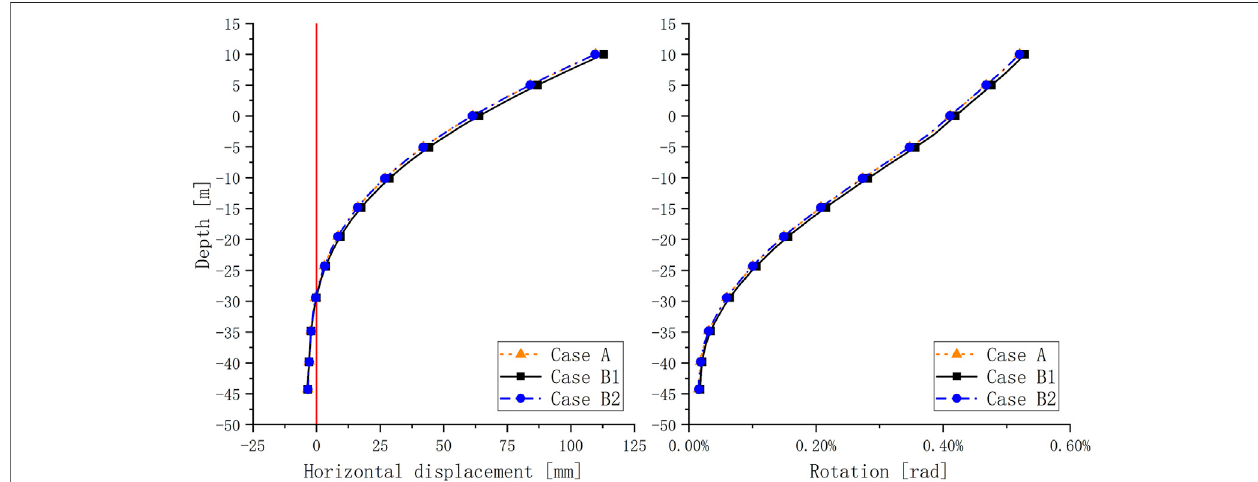
FIGURE 7 | The deformations of the monopile in the serviceability limit state (SLS).